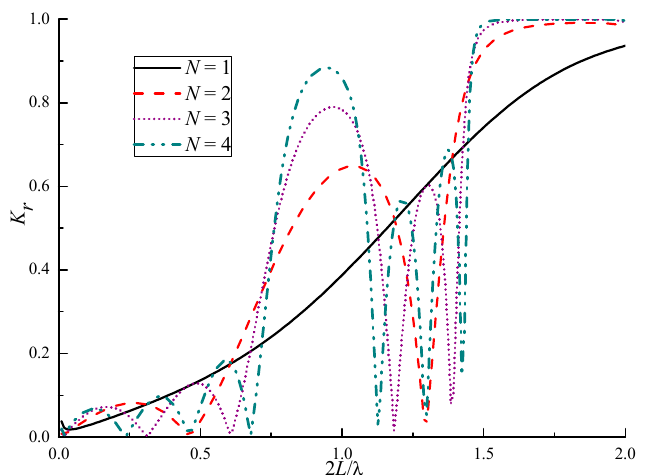
Figure 6. Reflection coefficient versus 2 L / λ under different numbers of plates ( d / h = 0.5 and L / h =